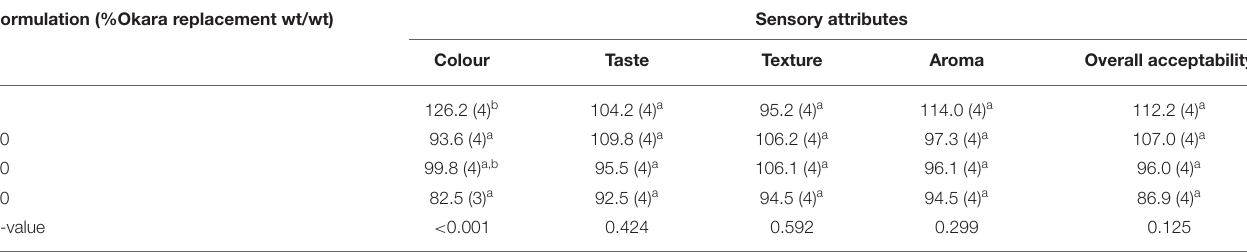
Values are mean ranks and values in parenthesis are medians. Mean ranks in the same column with the same letters are not significantly different after Kruskal Wallis analysis and compared using the Dunn’s test (p > 0.05). 1-dislike extremely, 2-dislike, 3-neither like nor dislike, 4-like, 5-like